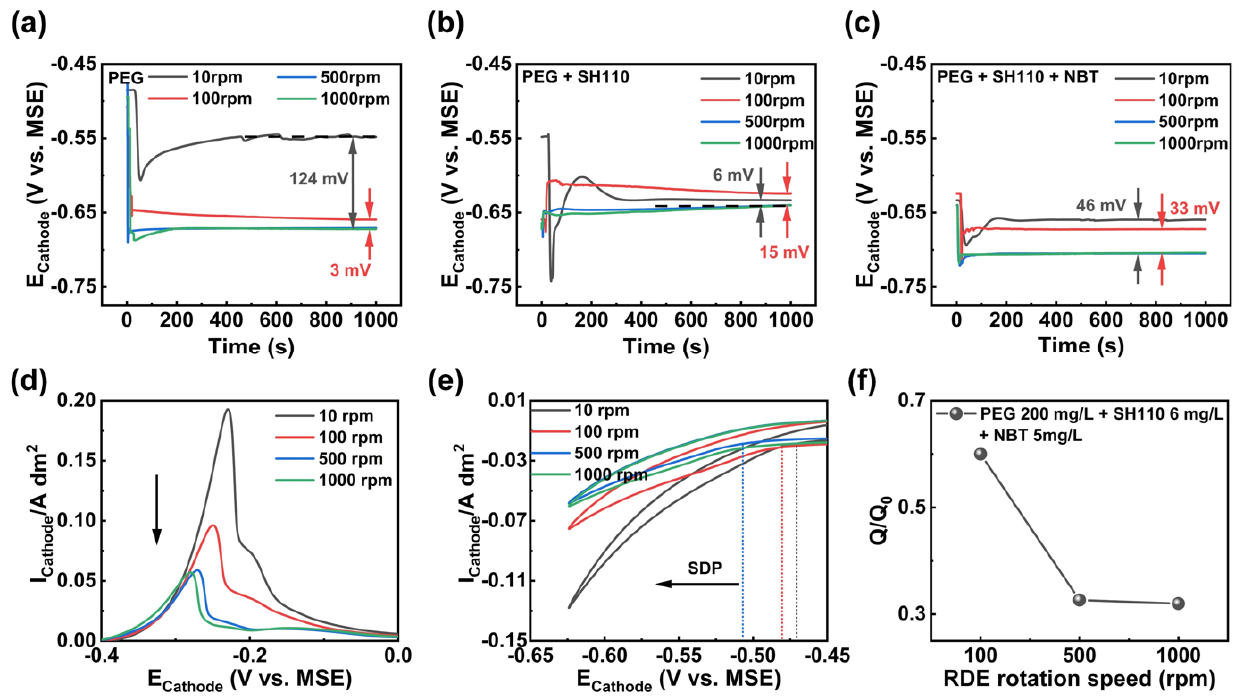
Figure 4. GMs curves ( a – c ) and CV curves ( d – f ) of the electroplating solution with multiple RDE rotation speeds. ( a ) PEG, 200 mg/L + Cl − , 50 mg/L; ( b ) PEG, 200 mg/L + SH110, 6 mg/L + Cl − , 50 mg/L; ( c – e ) PEG, 200 mg/L + SH110, 6 mg/L + NBT, 5 mg/L + Cl − , 50 mg/L; ( f ) Q/Q 0 as a function of RDE rotation speed.